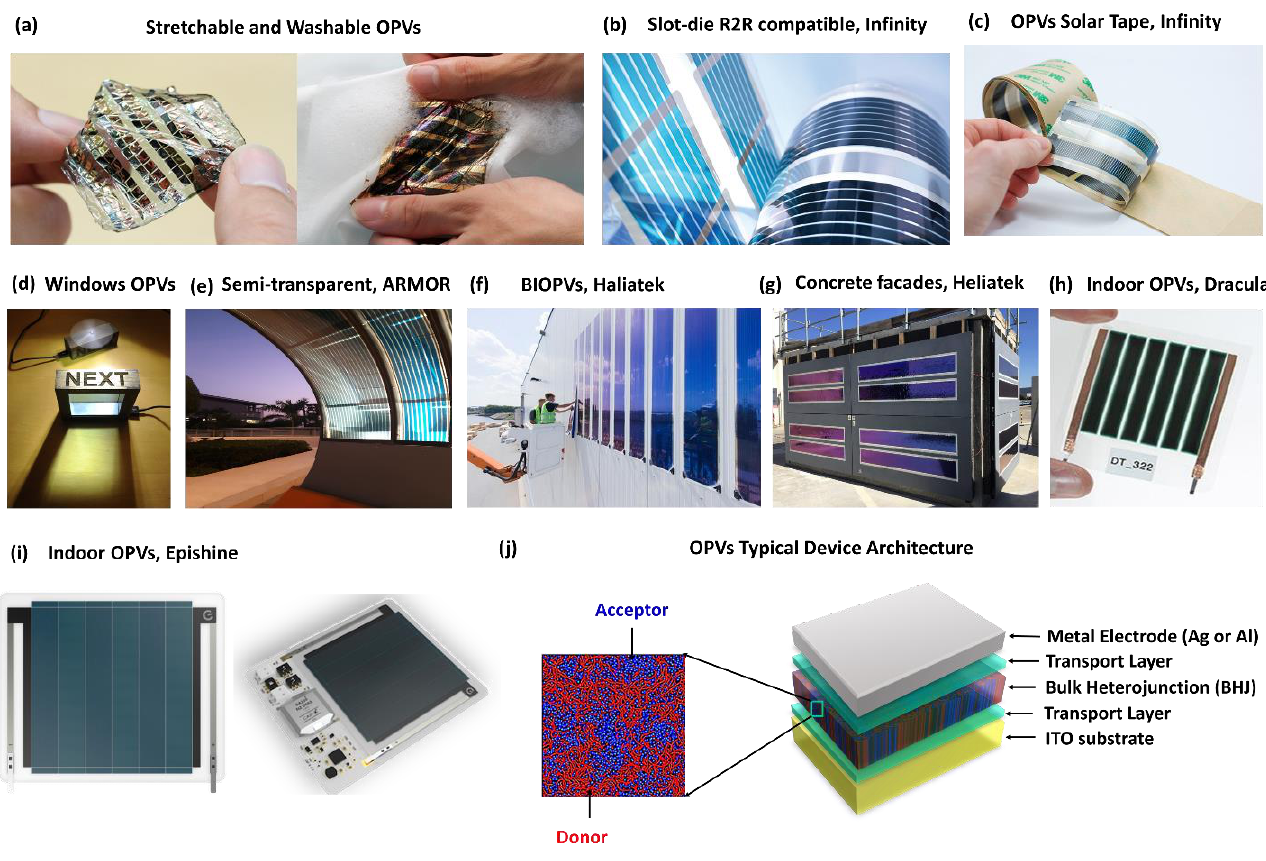
Figure 1. Examples showing versatile applications of OPVs: ( a ) stretchable and washable OPV devices for wearable applications [9], ( b ) slot-die-coated flexible OPV modules from InfinityPV, ( c ) OPV solar tape from InfinityPV, ( d ) transparent OPV windows by Next Energy Technologies, Inc., ( e ) semi-transparent OPVs by ARMOR, ( f , g ) building-integrated OPVs (BIOPVs) by Heliatek, ( h ) indoor OPV mini module by Dracula, ( i ) mini modules for integrated indoor IoT sensors by Epishine, and ( j ) schematic illustration of a typical OPV device architecture (active layer morphology is shown as zoomed-in image) [24]. Images in ( a , j ) reproduced with permission from [9,24]. Copyright 2017, Springer Nature and 2011, Royal Society of Chemistry. All images are used with permission.